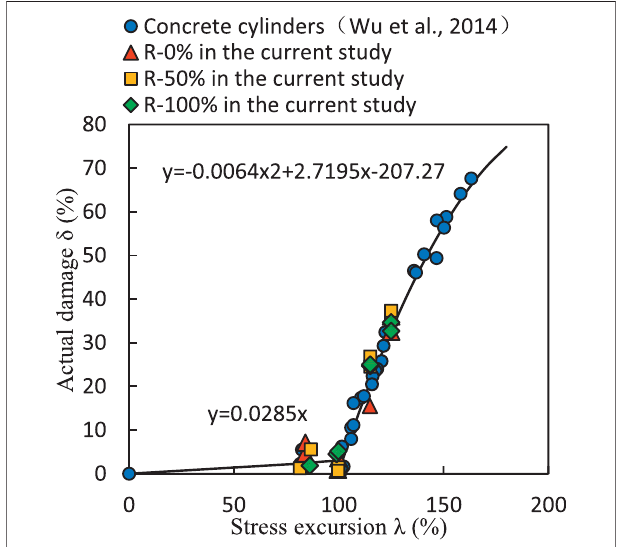
Figure 6 | Relationship between stress excursion and actual damage. FRP-repaired damaged concrete columns.